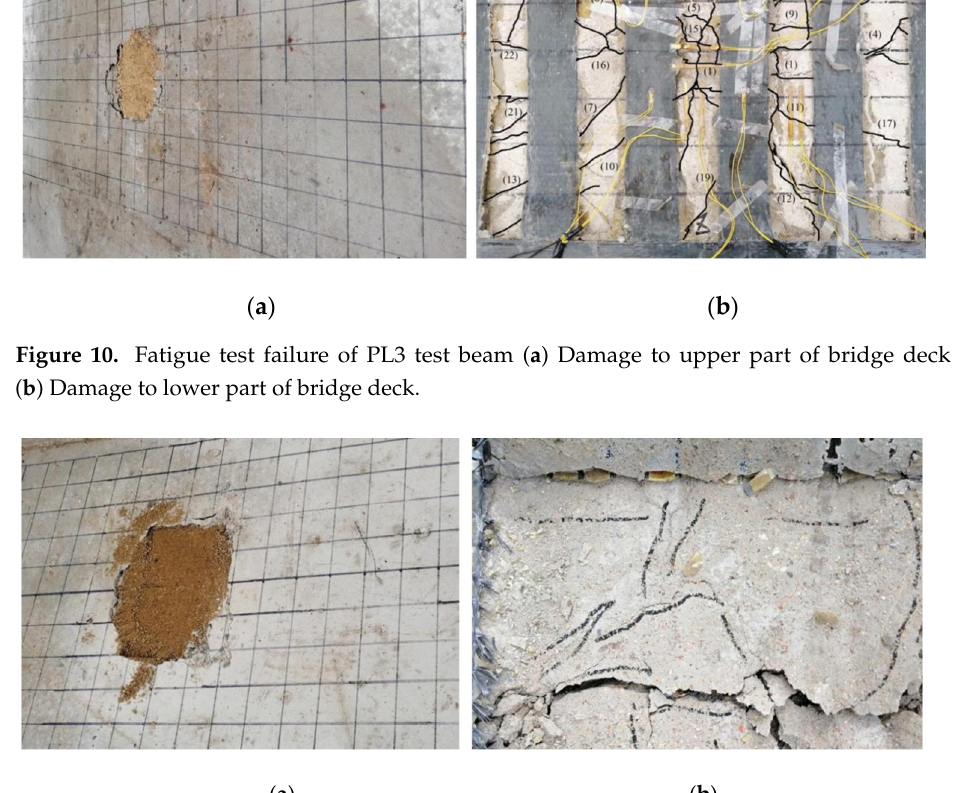
Figure 11. Fatigue test failure of PL4 test beam ( a ) Damage to upper part of bridge deck and ( b )